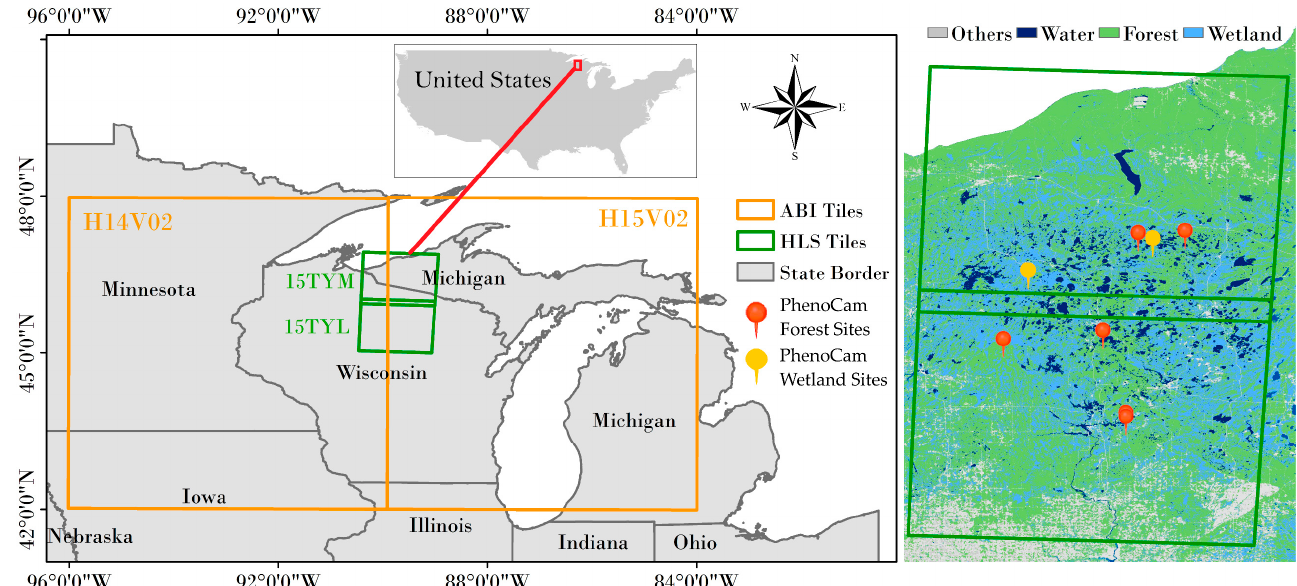
Figure 1. The study area map. Green rectangle area delineates two Harmonized Landsat Sentinel-2 (HLS) tiles (15TYM and 15TYL), orange rectangle area delineates two Advanced Baseline Imager (ABI) tiles (H14V02 and H15V02) covering both HLS tiles. Right parts show the available 8 PhenoCam sites and the dominated land cover types from 30m Crop Data Layer (CDL) (Section